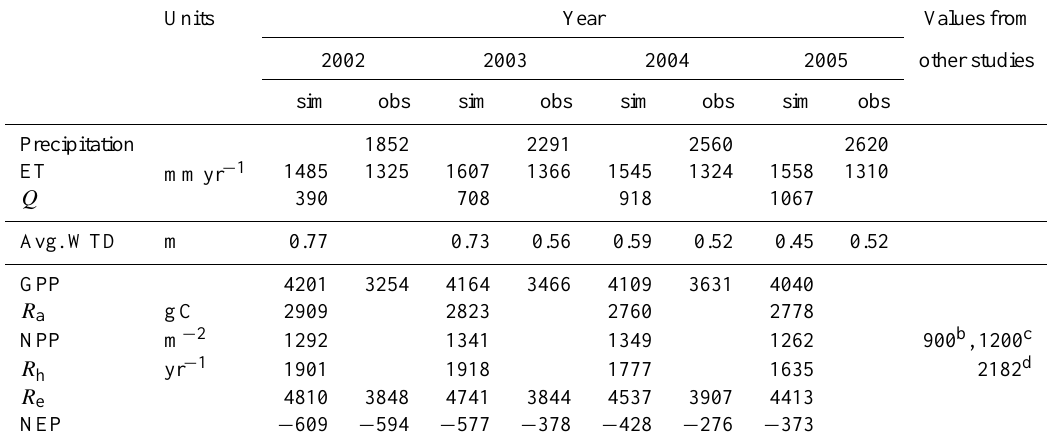
Table 3. Simulated (sim) and observed (obs) annual water and C balance over a drainage affected tropical peat swamp forest at Palangkaraya, Indonesia a . Units Year Values from 2002 2003 2005 other studies sim obs sim obs sim obs sim obs Precipitation mmyr − 1